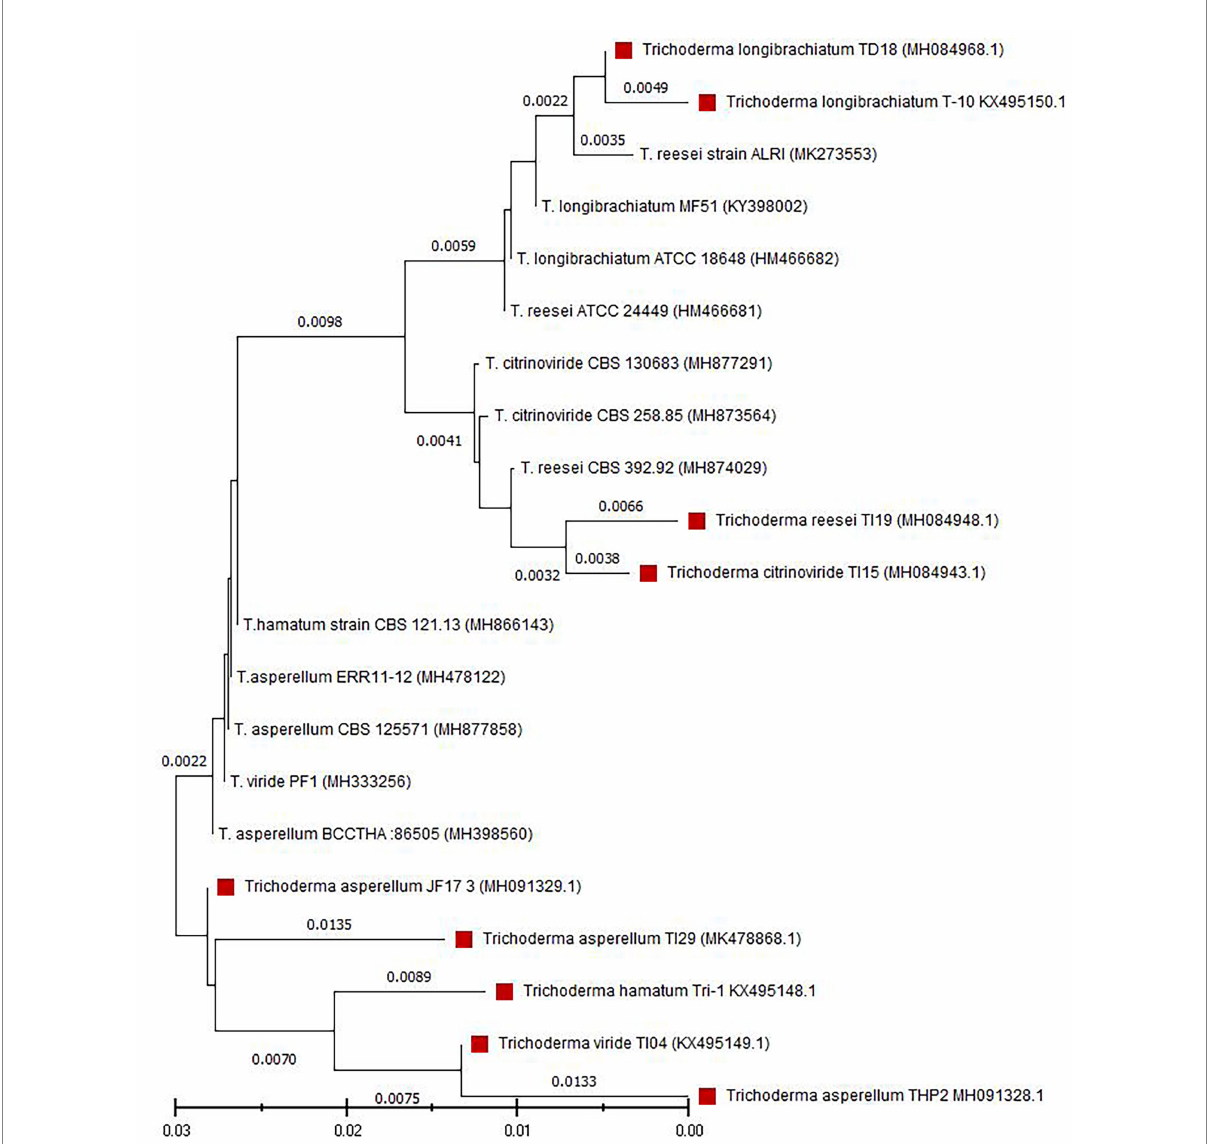
FIGURE 1 Phylogenetic analysis of nine Trichoderma isolates. Tree was constructed by the neighbor-joining method. The numbers given over branches indicate bootstrap